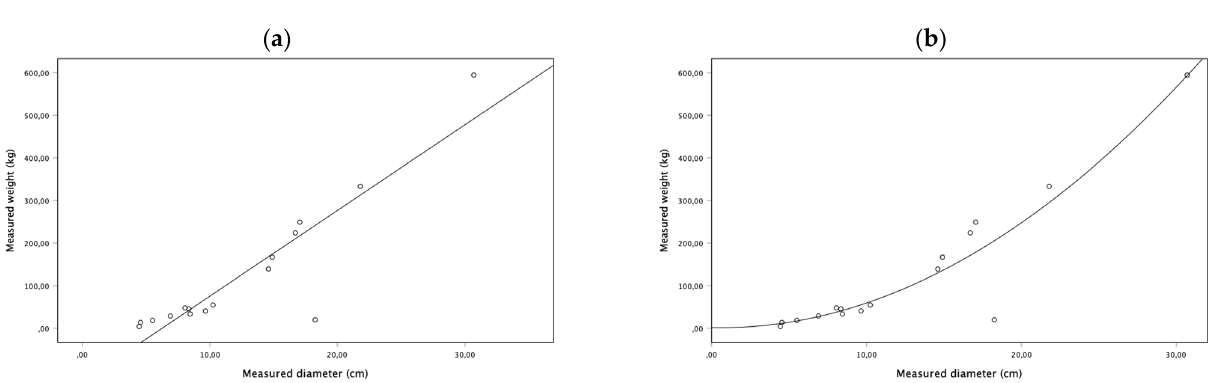
Figure 10. ( a ) Establishment of a linear relationship between the measured weights of the samples collected and the diameters of these samples; and ( b ) the establishment of a quadratic-type relationship between the measured weights of the collected samples and the diameters of these same samples.